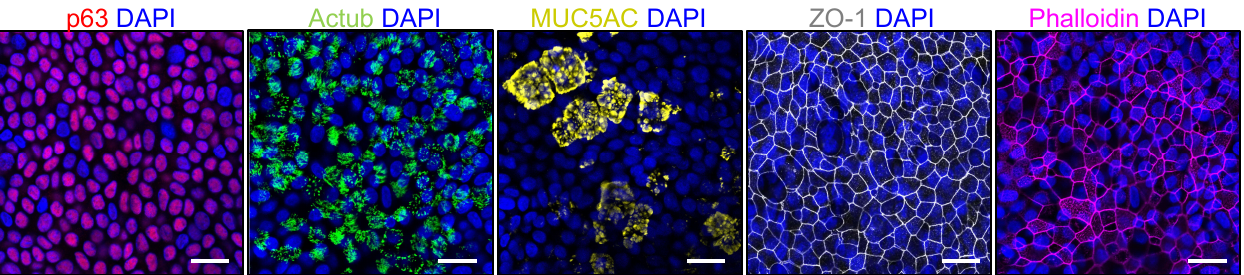
Figure 1. Characterisation of airway epithelial cells differentiated at air-liquid interface. Representative confocal images of acetylated tubulin (actub, ciliated cells), MUC5AC (secretory goblet cells), p63 (basal cells), ZO-1 (tight junction) and phalloidin (actin). 63x/1.4 objective. Scale bars: 20 µm.